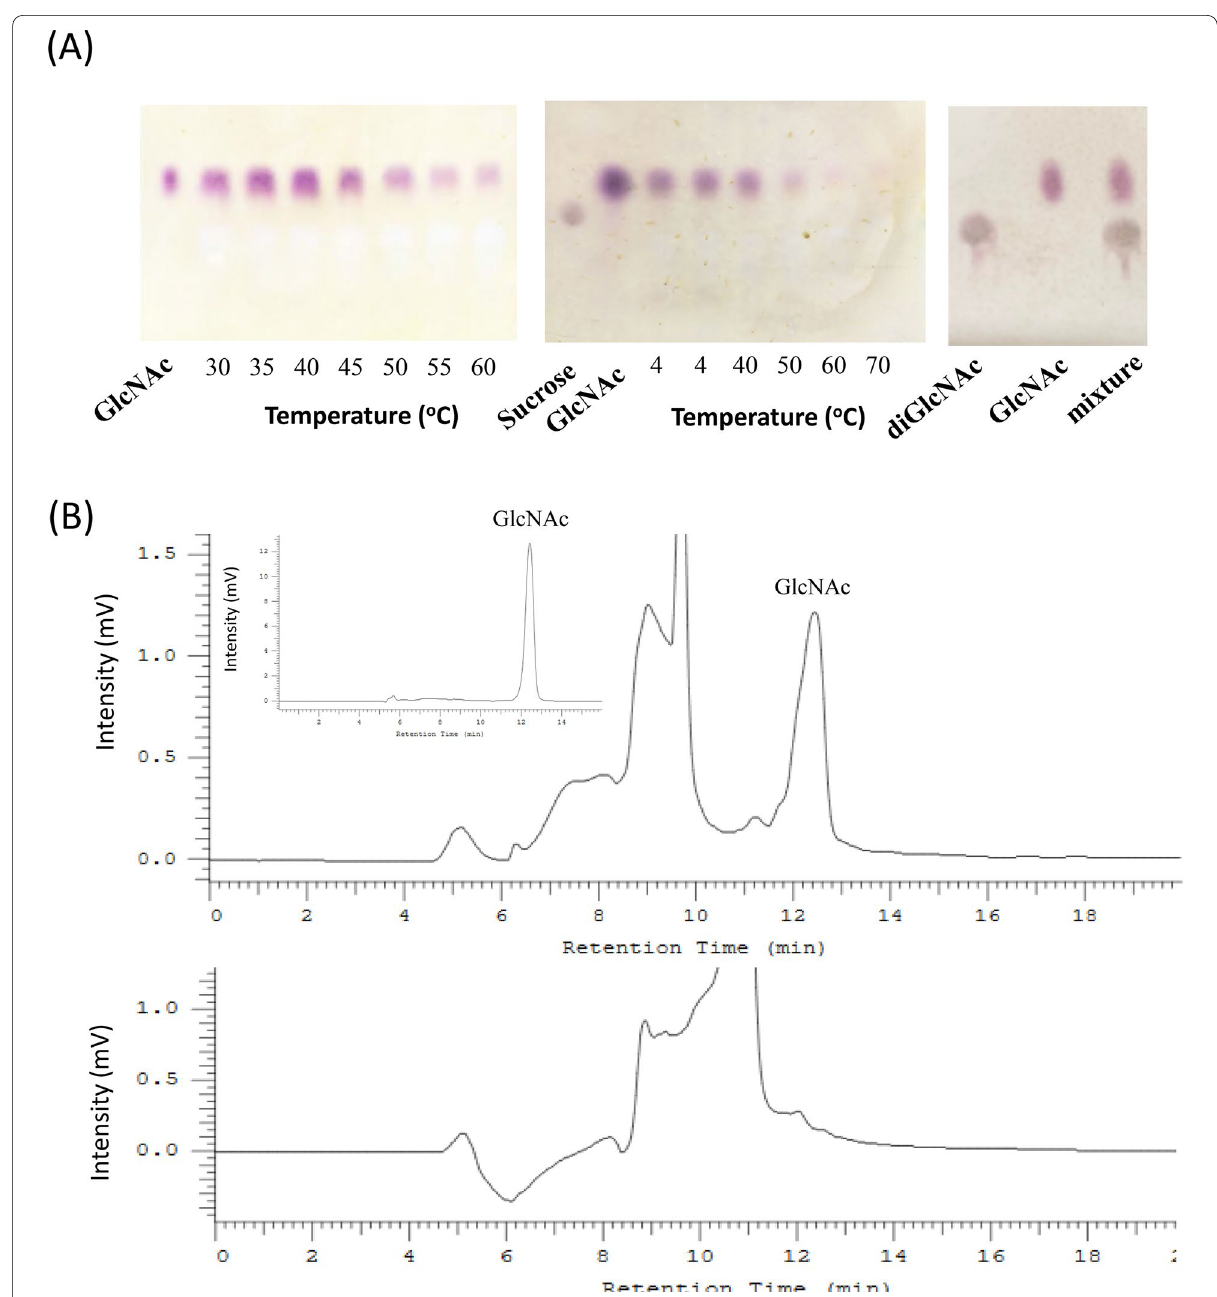
Fig. 5 TLC and HPLC analyses of product hydrolyzed by TvmNAG2 using colloidal chitin as the substrate. A TvmNAG2 was incubated with 1.5% colloidal chitin at 30–60 °C for 20 h, followed by TLC analysis (left). TvmNAG2 was treated at 4, 40, 50, 60 and 70 °C for 2 h. Afterward, TvmNAG2 was incubated with 1.5% colloidal chitin at 40 °C for 20 h, followed by TLC analysis (middle). diGlcNAc ( N , N ’‑diacetylchitibiose), GlcNAc and mixture (diGlcNAc and GlcNAc) was on TLC analysis as well (right). B TvmNAG2 was incubated with 1.5% colloid chitin at 37 °C for 20 h, followed by HPLC analyses (upper). For comparison, GlcNAc was used as the standard sample. The colloid chitin was as the control